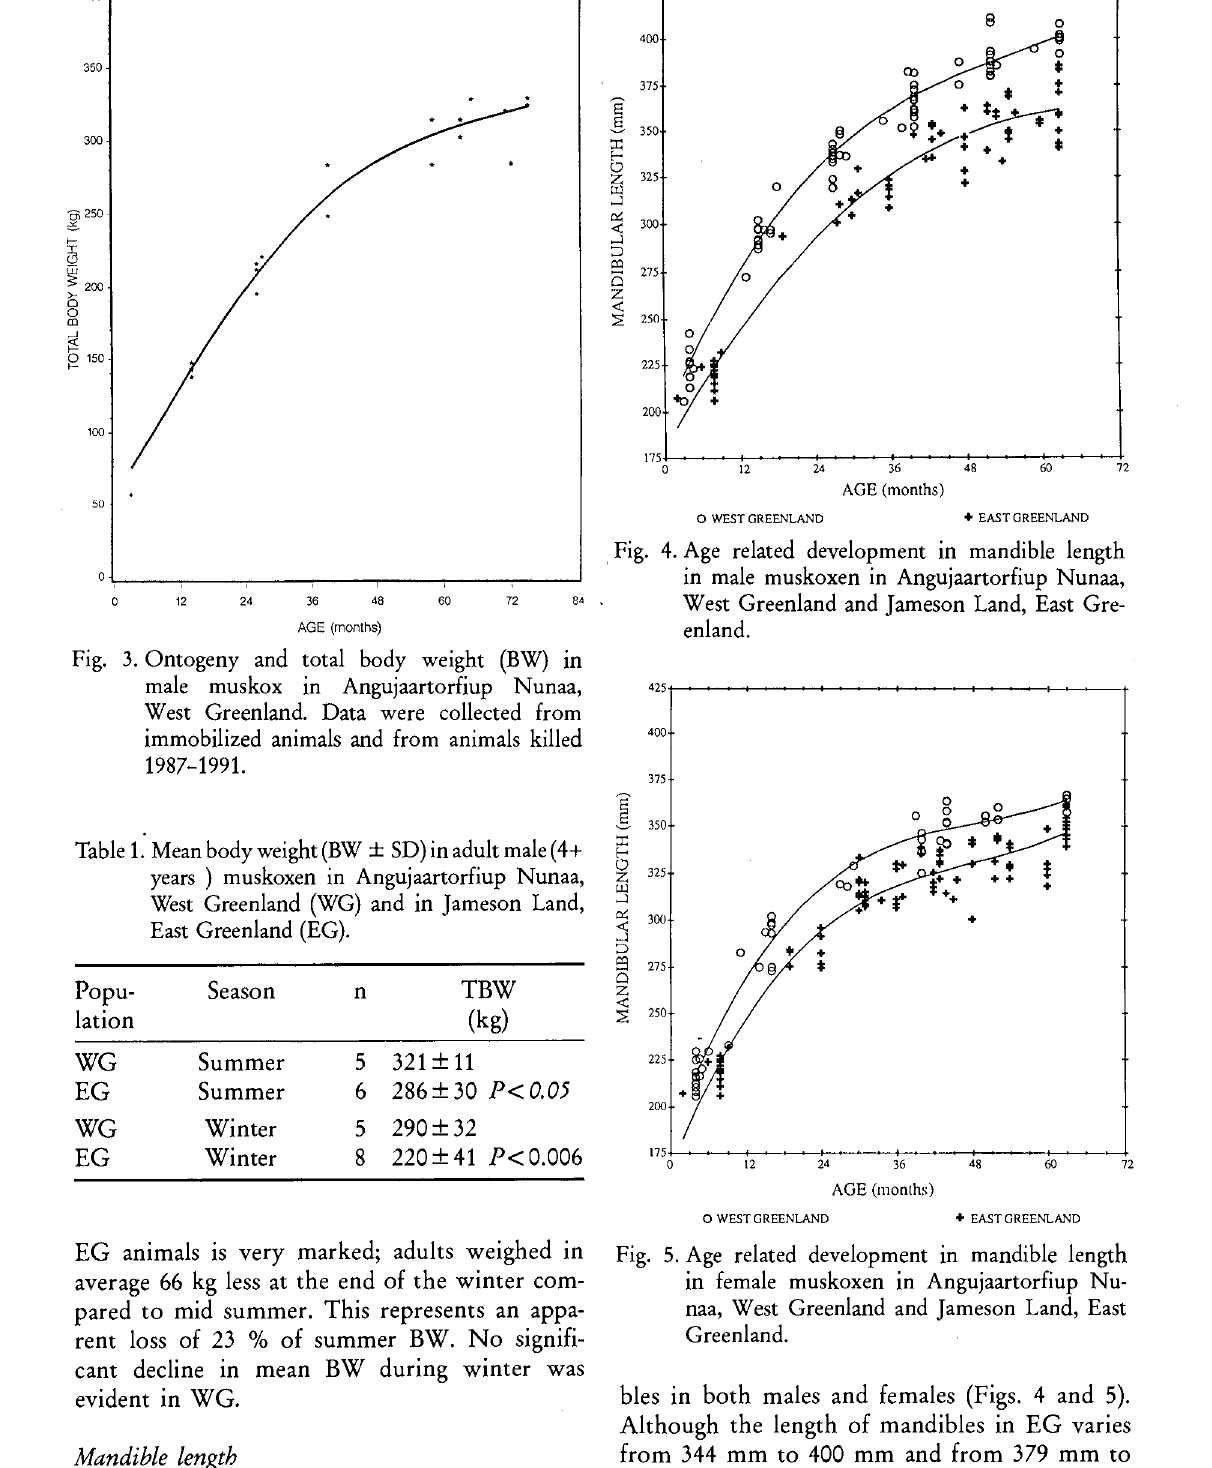
Fig. 5. Age related development in mandible length in female muskoxen in Angujaartorfiup Nu naa, West Greenland and Jameson Land, East Greenland. bles in both males and females (Figs. 4 and 5). Although the length of mandibles in EG varies from 344 mm to 400 mm and from 379 mm to 411 mm in WG it is evident that only a limited range overlap in mandible length of 3+